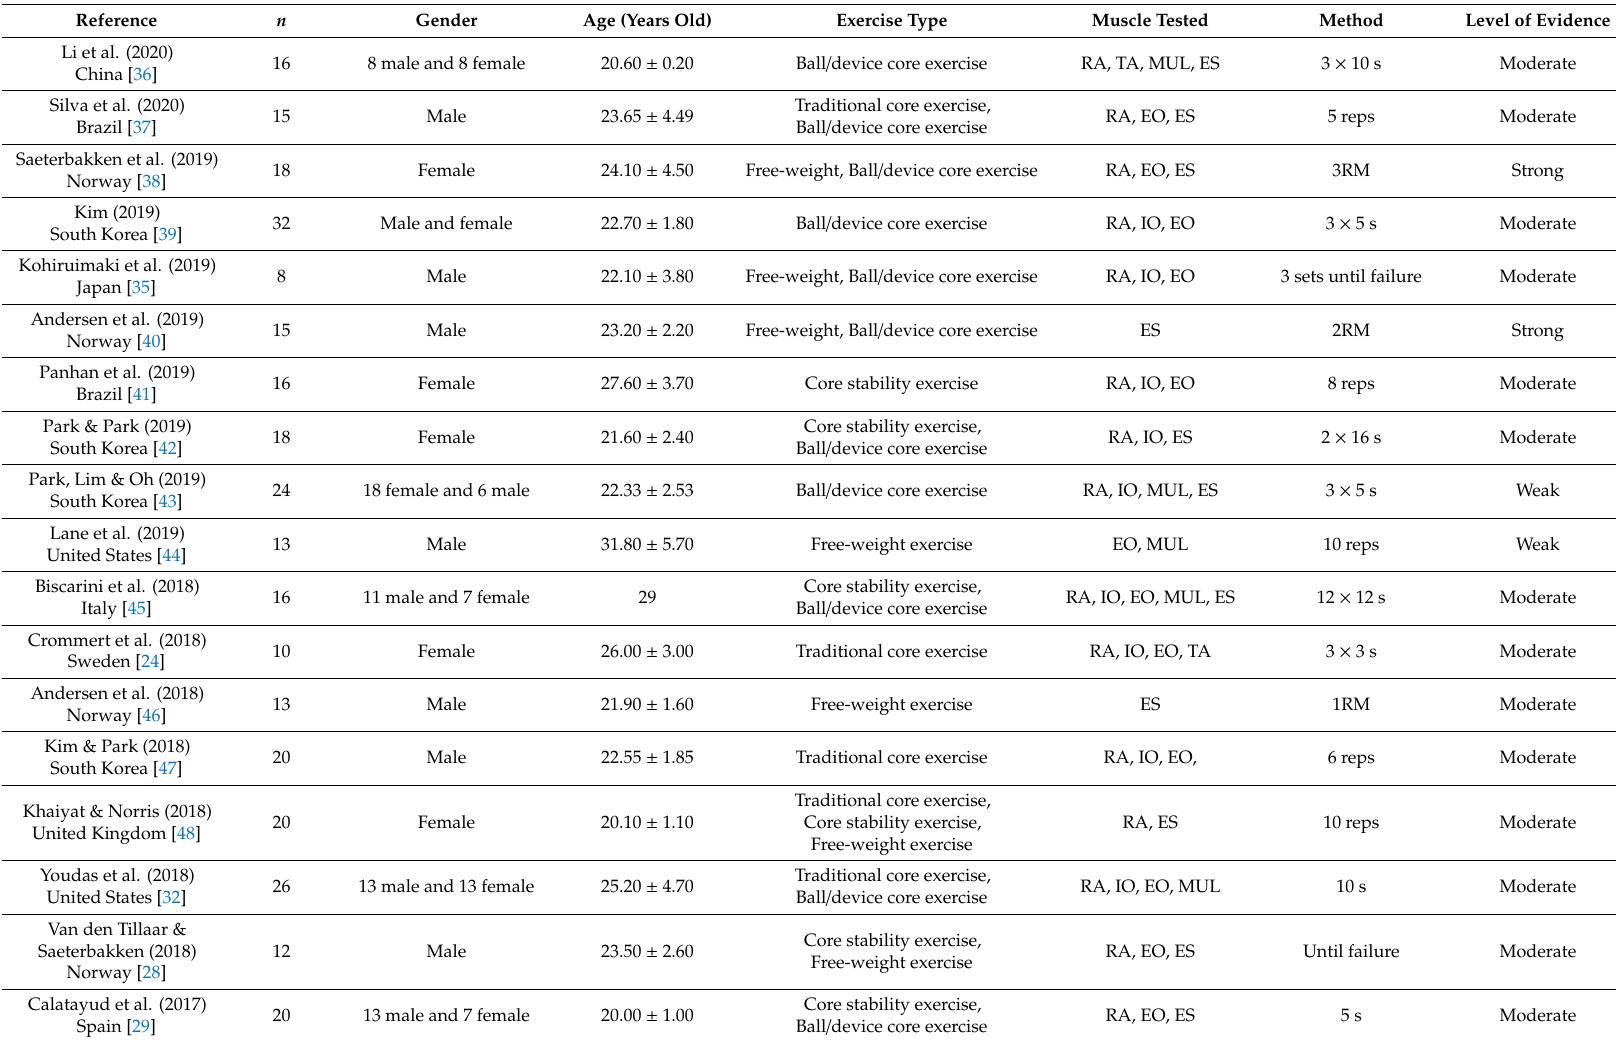
Table 1. Characteristics of the included